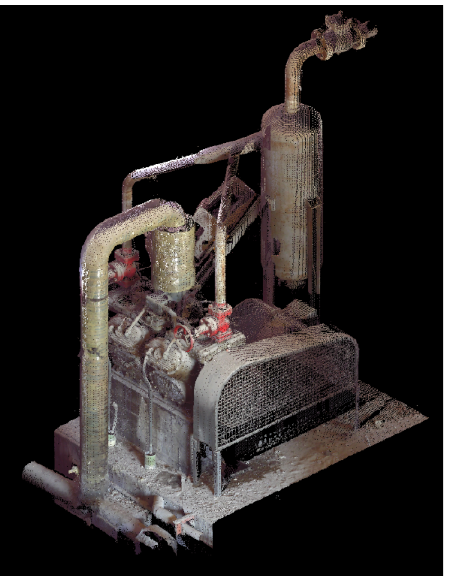
Figure 13. 3-D view of a single element of the machine room.